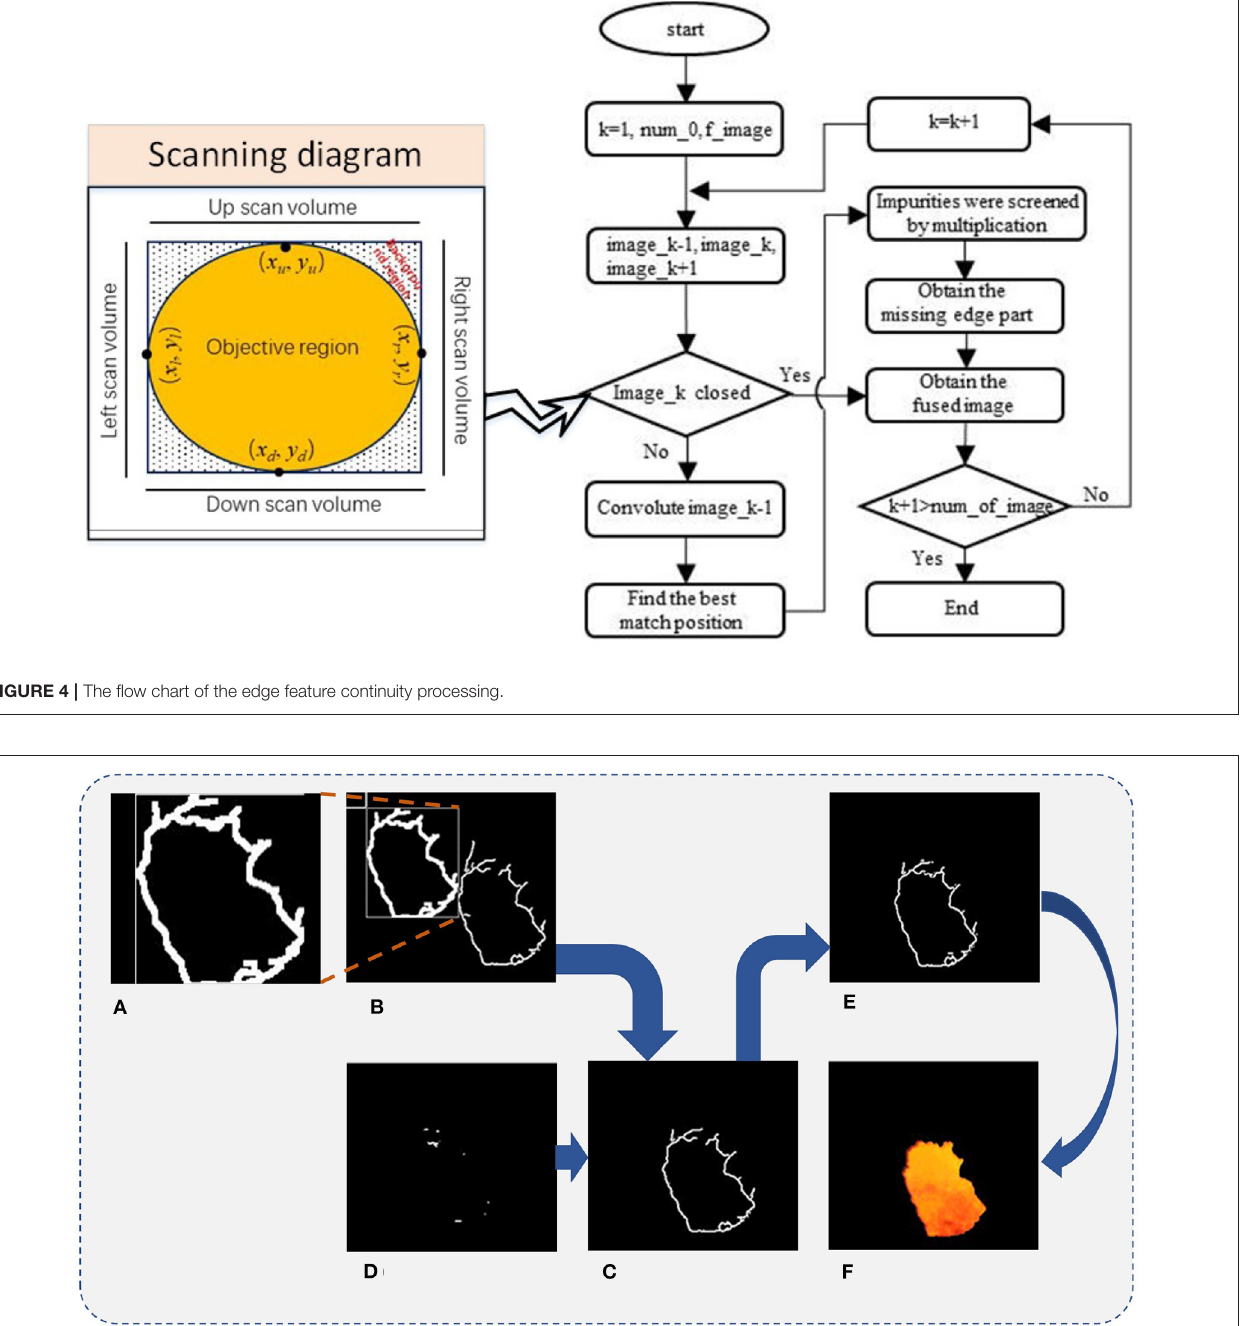
Frontiers in Neurorobotics |